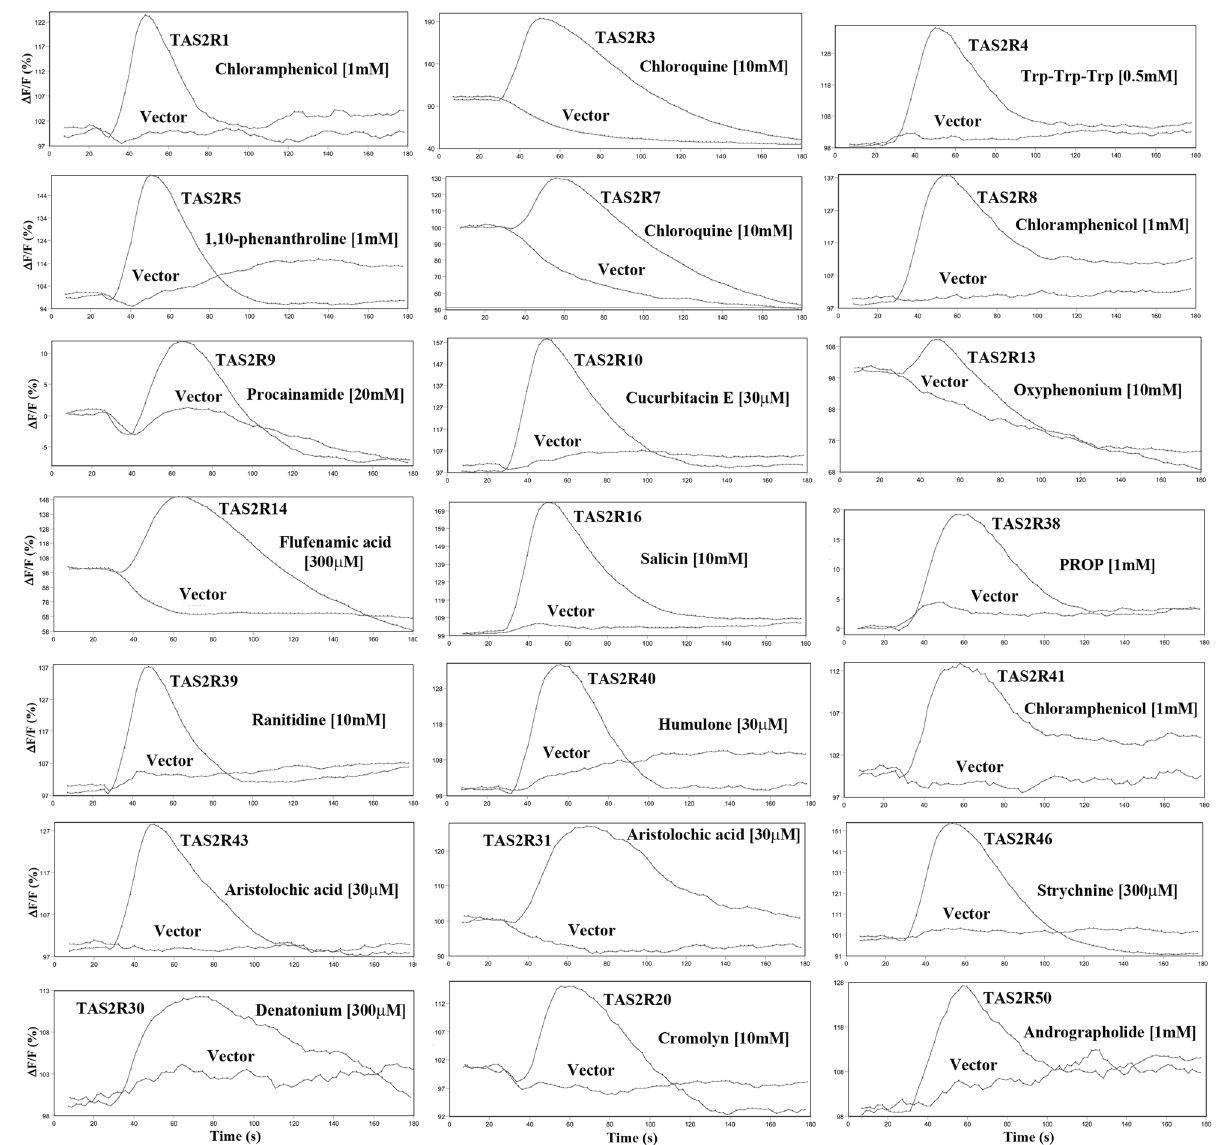
Figure 2. Functional results of deorphanized TAS2Rs (TAS2Rs) response to their representative bitter compounds, comparing with empty pcDNA vector as a negative control. The TAS2R DNAs, G16-gust44, and GCaMP calcium sensor were co-expressed in HEK293E cells. The fluorescence signal changes were measured by adding representative bitter compounds to the corresponding TAS2Rs, using a FlexStation 3 microplate reader (96 well